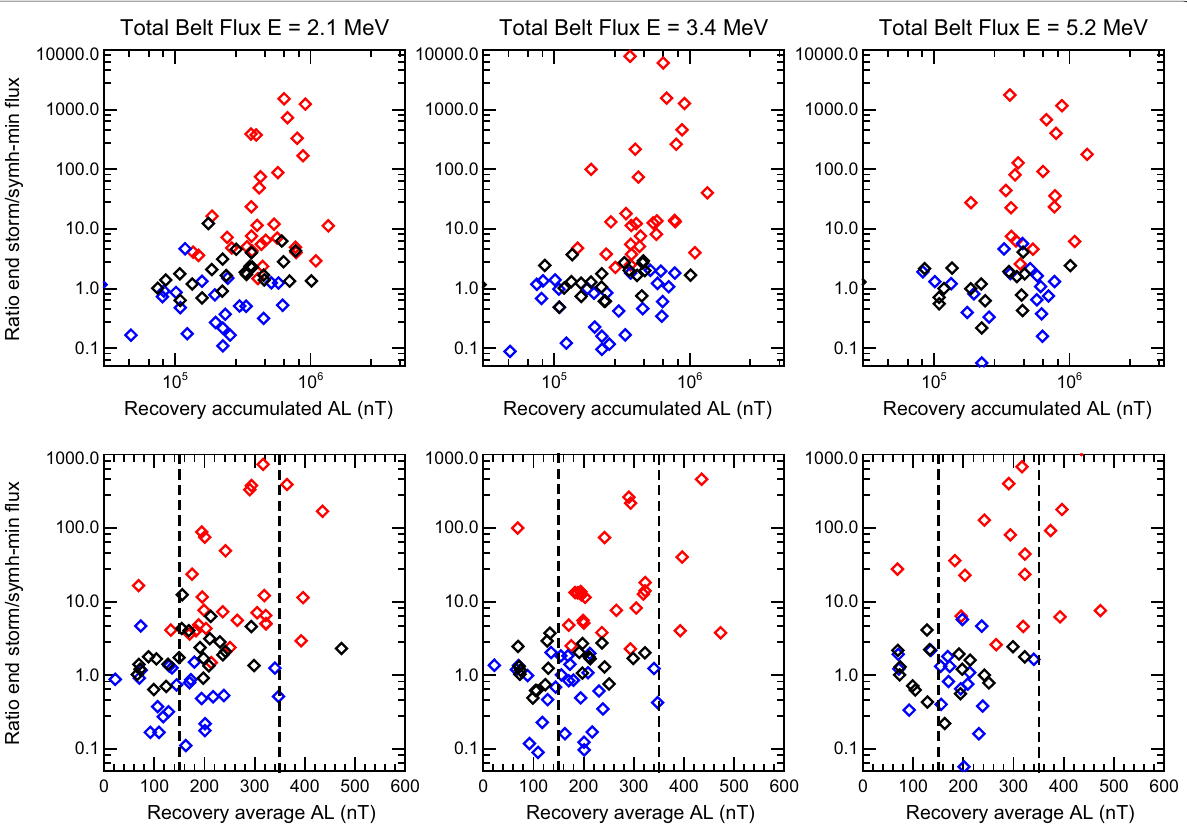
Fig. 4 Relation between integrated |AL| index (top) and average |AL| index (bottom) during the recovery phase of each storm event, and the post-storm/minimum flux ratio integrated between L Red, blue and black squares represent enhancement, depletion and no-change events, respectively. Vertical dashed lines separate the distribution in three groups, according to their average |AL|